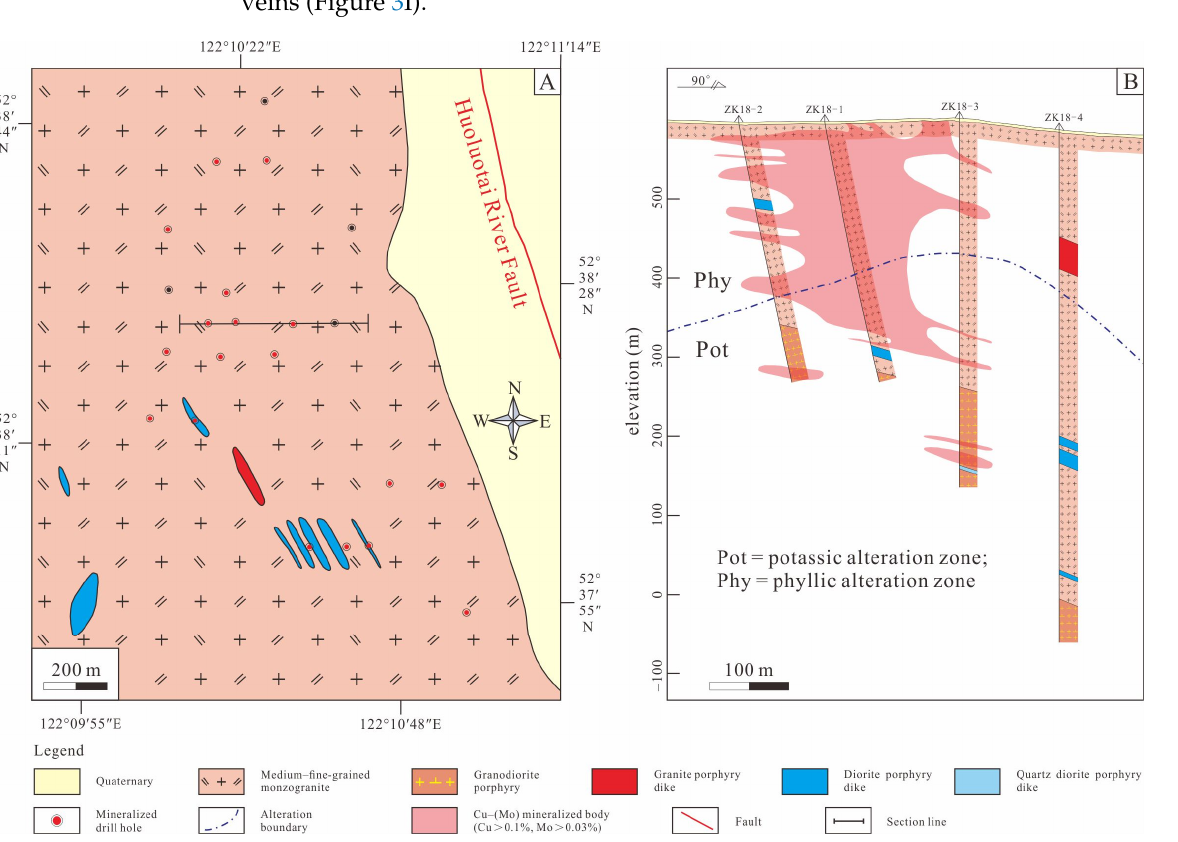
Figure 2. ( A ) Geological map of the Huoluotai Cu (Mo) deposit (modified from [8]). ( B ) Geological sections in the Huoluotai Cu (Mo) deposit (modified from